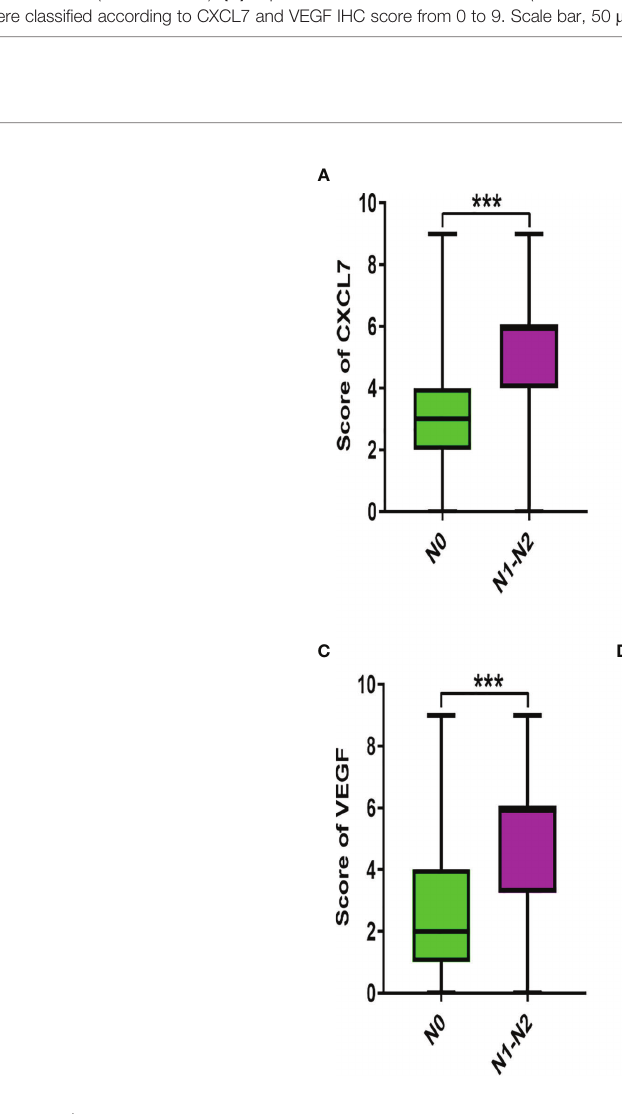
FIGURE 2 | Associations between CXCL7 and VEGF and clinicopathological characteristics. (A) Expression of CXCL7 in different N-stage tumors. (B) Expression of CXCL7 in different TNM stages. (C) VEGF in N0 and N1-N2 stage tumors. (D) VEGF in I-II and III-IV stages. The Mann ‐ Whitney U-test was used for analysis. *** P <